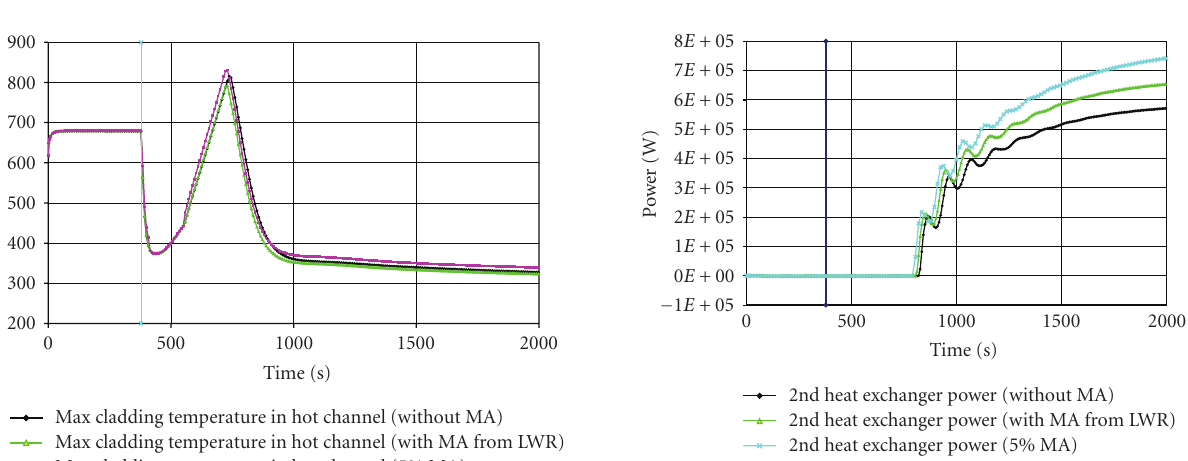
Figure 7: Maximum fuel temperature in hot channel.